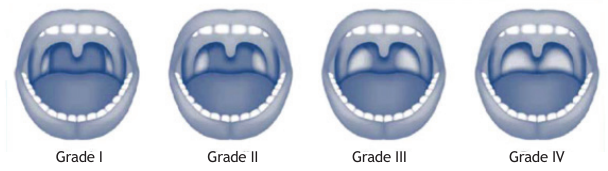
Figure 3 Grading system for palatine tonsils.